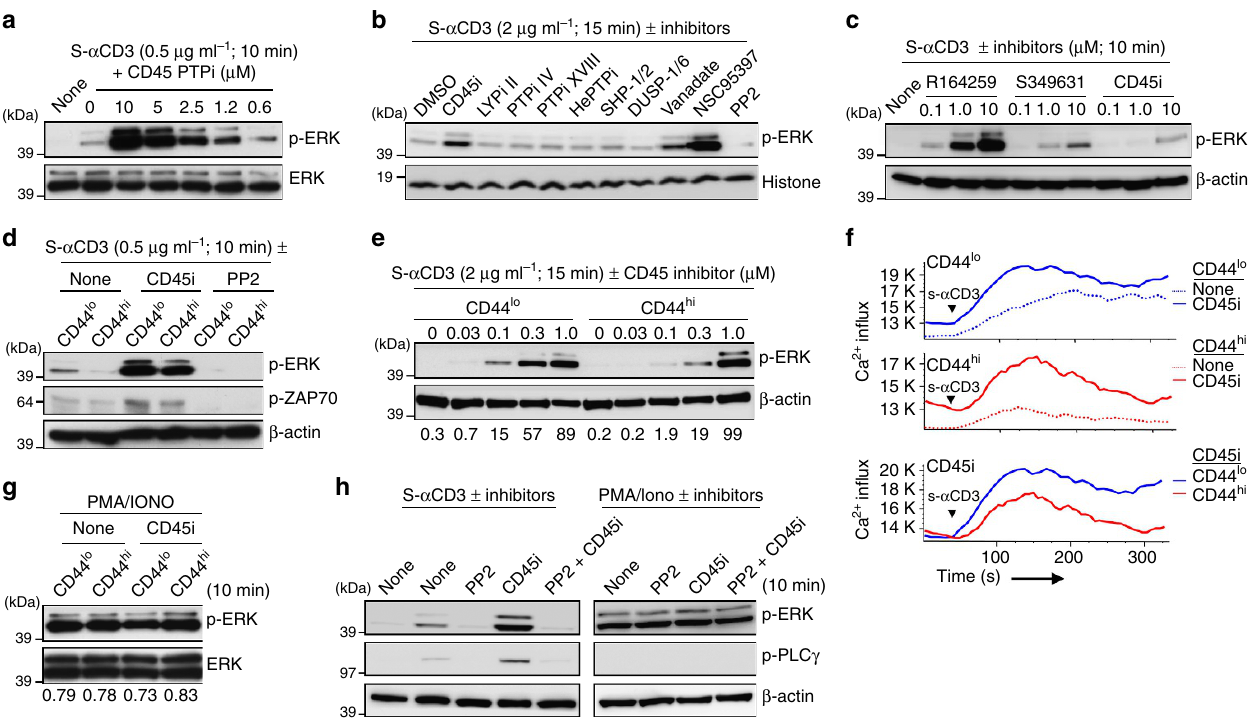
Figure 6 | Effects of CD45 inhibitors on TCR sensitivity of CD8 þ Tcell subsets. ( a ) ERK phosphorylation in B6 naı¨ve CD8 þ Tcells after incubation with S- a CD3 mAb ± CD45 PTP inhibitor (CD45i). ( b ) ERK phosphorylation in B6 naı¨ve CD8 þ Tcells after incubation with S- a CD3 mAb ± various PTP inhibitors indicated (5–10 m M); note that increased p-ERK was observed only with CD45-specific inhibitors, CD45i and NSC95397, and as a control, vanadate. ( c ) ERK phosphorylation in B6 naı¨ve CD8 þ T cells after incubation with S- a CD3 mAb (0.5 m gml (cid:2) 1 ) ± CD45-specific inhibitors, R164259, S349631 and CD45i. ( d , e ) ERK ( d , e ) and ZAP-70 ( d ) phosphorylation in CD44 lo and CD44 hi B6 CD8 þ Tcells after incubation with S- a CD3 mAb ± CD45i ( d , e ), or PP2 ( d ). ( f ) Ca 2 þ flux in CD44 lo (top) and CD44 hi (middle) CD8 þ T cells gated from Indo-1-loaded B6 LN cells in response to S- a CD3 and S- a CD8 mAbs (10 m gml (cid:2) 1 ) ± CD45i (2 m M). Ca 2 þ flux for both subsets with CD45i treatment is shown as overlay (bottom). ( g ) ERK phosphorylation in CD44 lo and CD44 hi B6 CD8 þ Tcells after incubation with PMA/IONO ± CD45i (10 m M). ( h ) ERK and PLC g phosphorylation in B6 naı¨ve CD8 þ Tcells after incubation with S- a CD3 mAb (2 m gml (cid:2) 1 ) or with PMA/ionomycin ± PP2 (2 m M), CD45i (5 m M), or both. Data are representative of four ( a , b , d ), three ( c , g , h ) and two